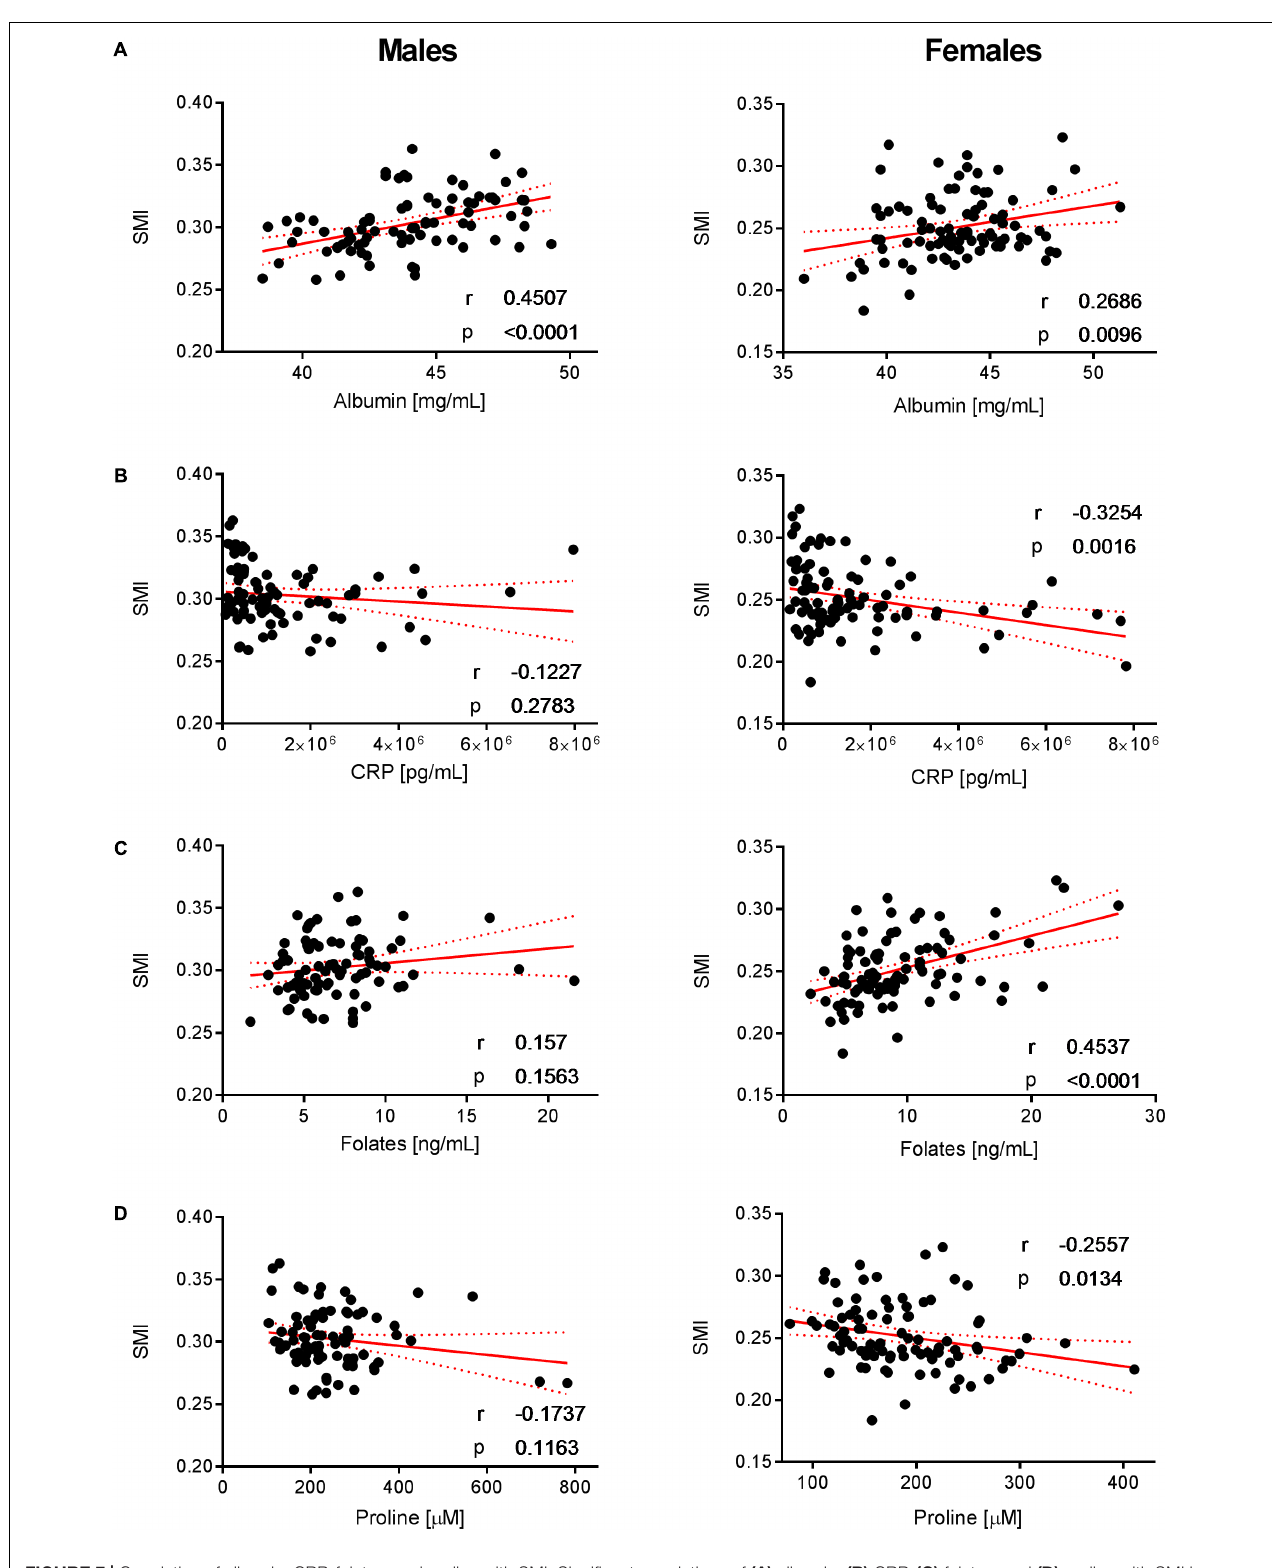
FIGURE 7 | Correlation of albumin, CRP, folates, and proline with SMI. Significant correlations of (A) albumin, (B) CRP, (C) folates, and (D) proline with SMI in females but not in males (with the exception of albumin that exhibits a positive correlation with SMI in both sexes). Pearson’ correlations (r) as well as two-tailed p -values are shown. N = 83 (males) and N = 93 (females). Each dot represents an individual sample. Red dotted lines show the 95% confidence interval.